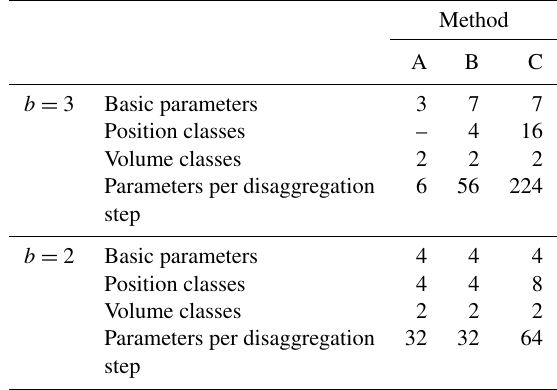
Table 2. Comparison of model parameters for methods A, B, and C in dependence of the applied branching